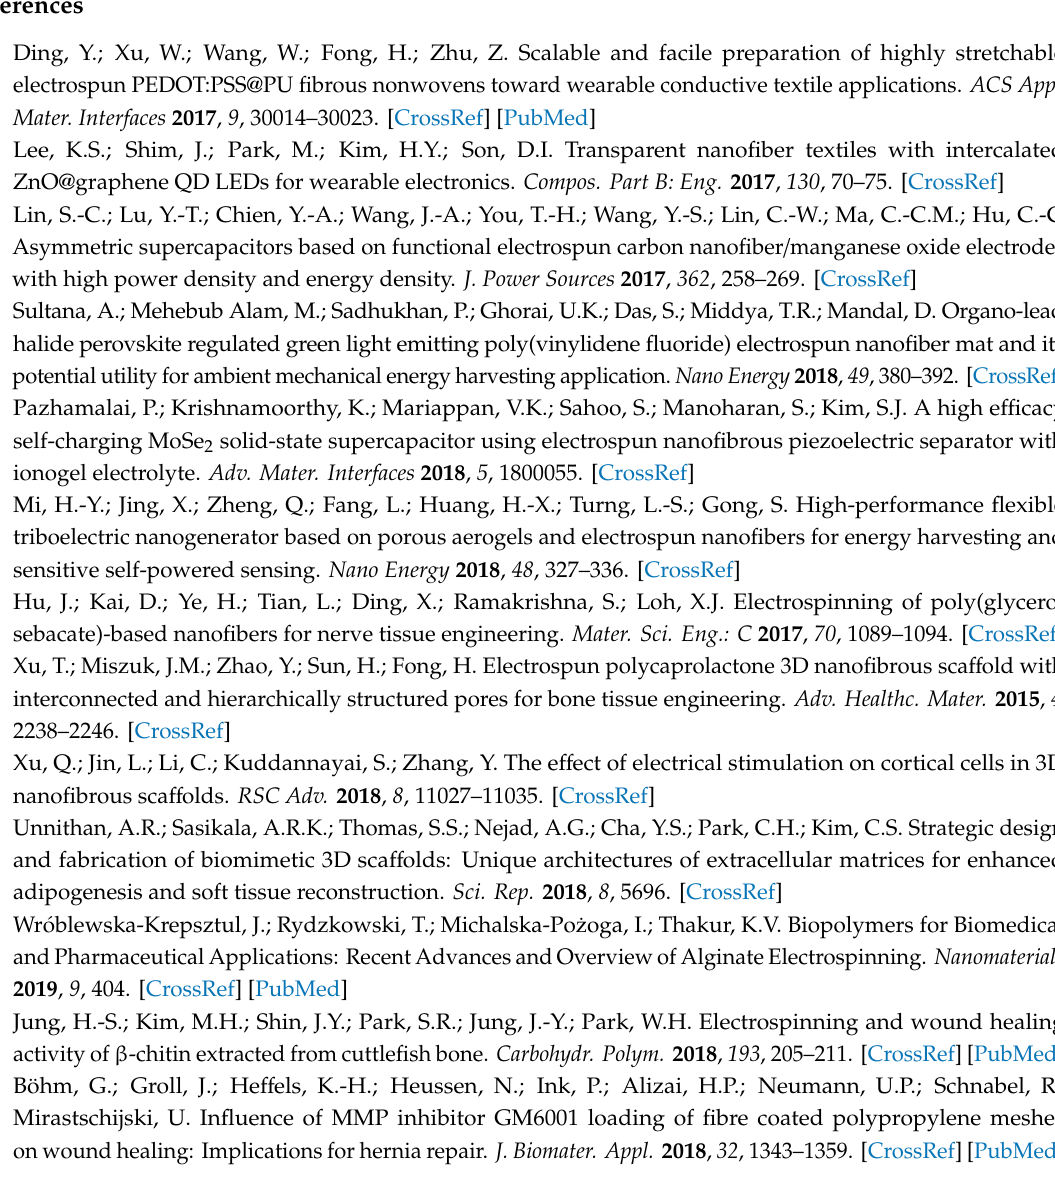
Figure S1: Circuit diagram of the main PCB. Figure S2: Main PCB layout. Figure S3: Front panel circuit schematic. Figure S4: Front panel PCB